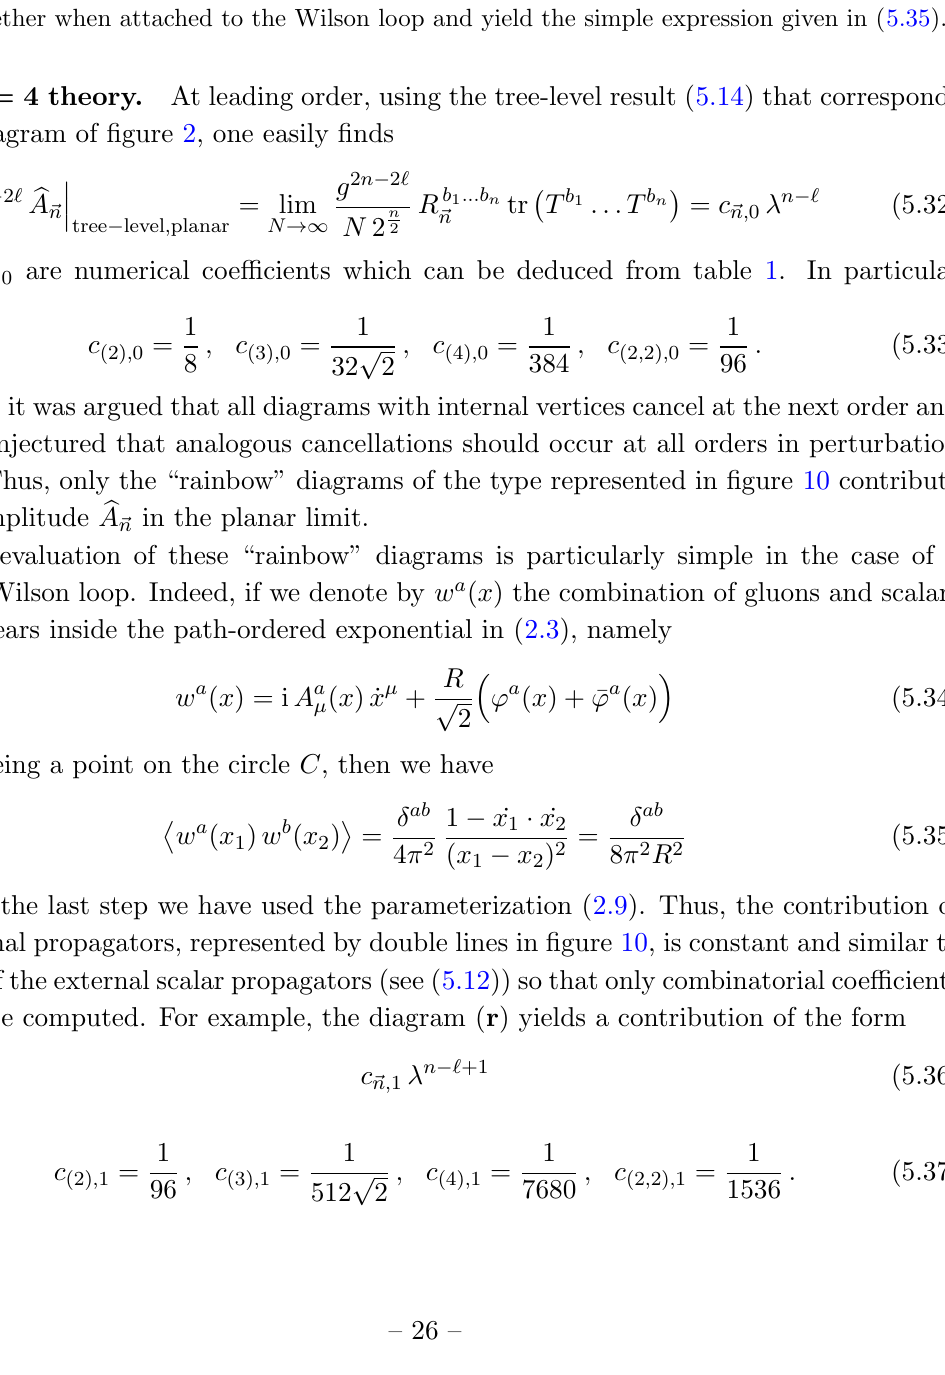
Figure 10 . In the planar limit of the N = 4 theory, the tree-level expression encoded in (cid:12)gure 2 gets corrected only by the so-called \rainbow" diagrams, the (cid:12)rst two of which are represented here. We have used a double line to denote the sum of the gluon and the scalar propagator, which always occur together when attached to the Wilson loop and yield the simple expression given in